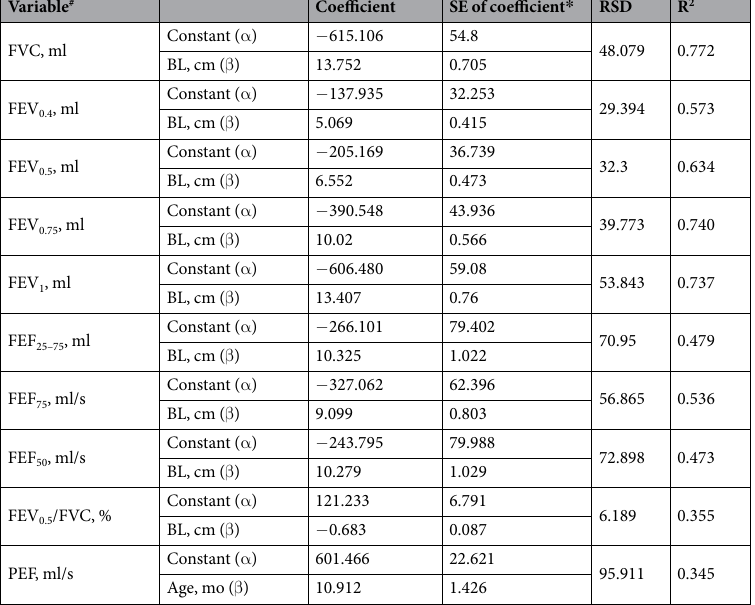
Table 2. Regression equations of various parameters of infant lung function. * All P < 0.001. # Function: variables = α + β × BL (or Age).